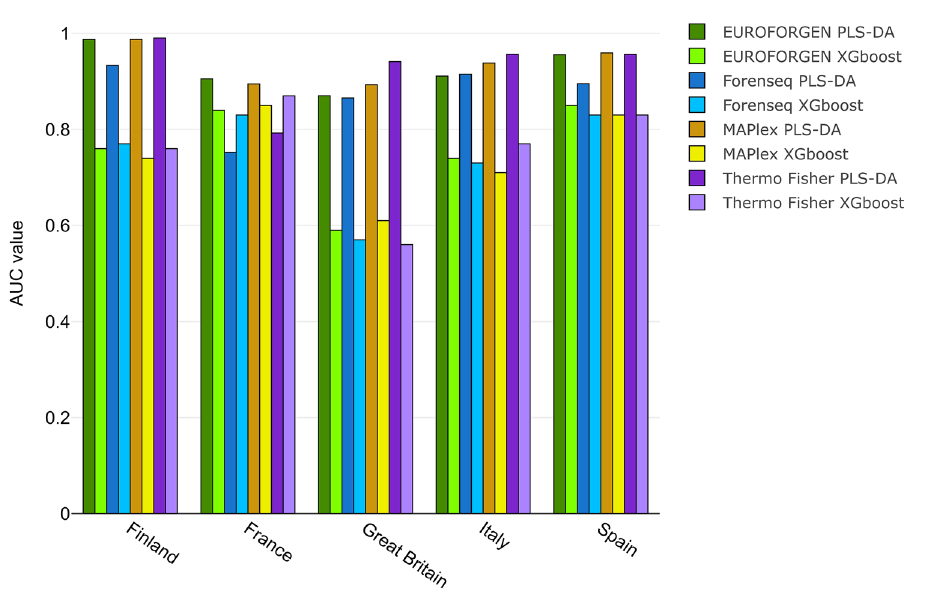
Figure 14. Comparison of AUC values obtained from PLS-DA and XGBoost model for European